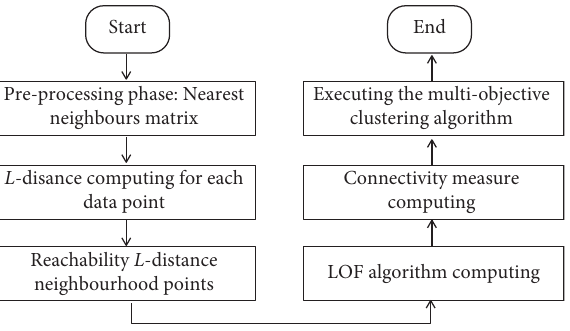
Figure 1: Flowchart of the proposed Conn_LOF